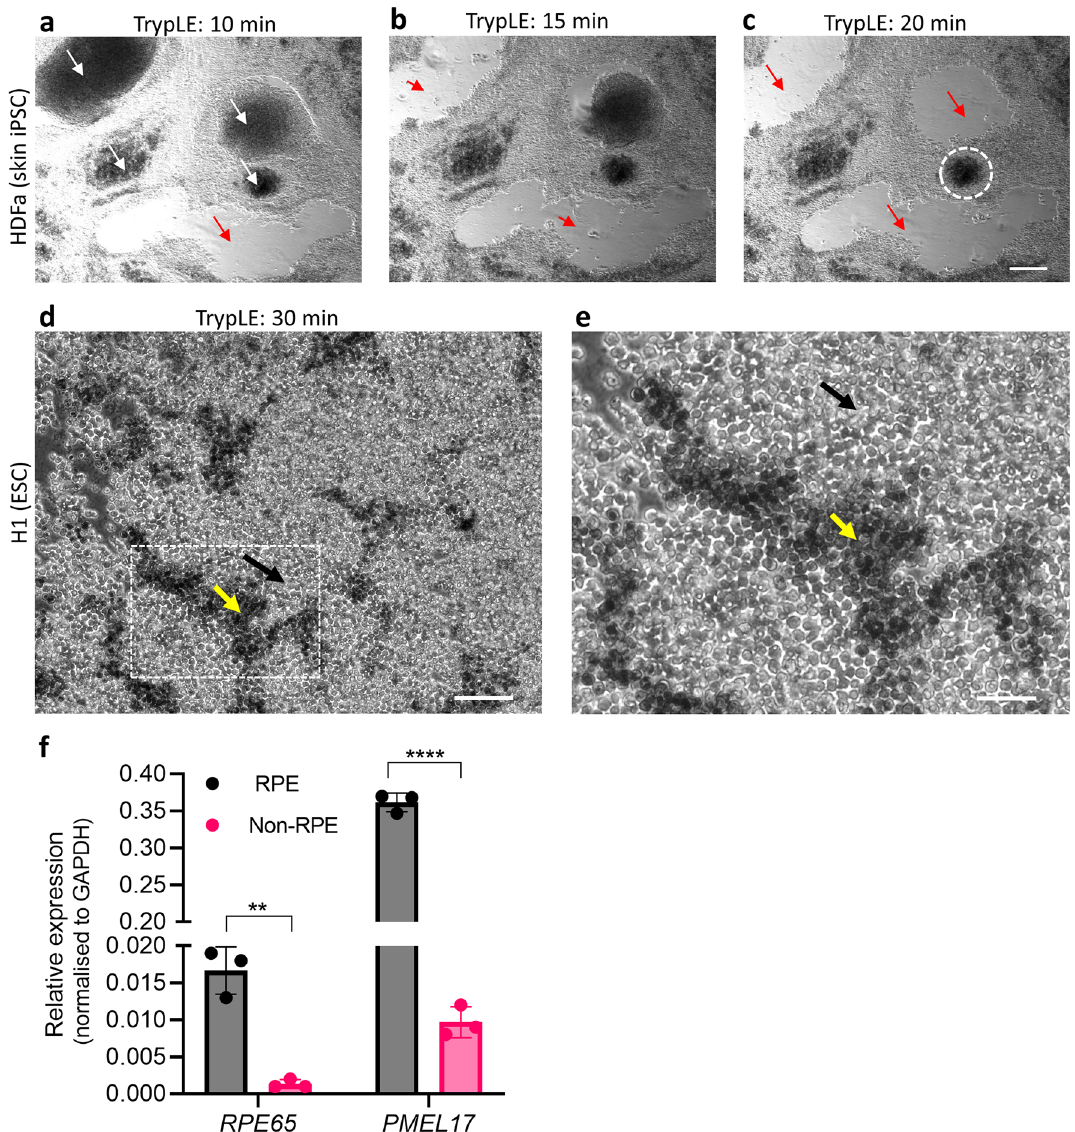
Figure 2. Heterogeneity in adherence of non-RPE cells from different stem cell sources. ( a ) Phase contrast images of HDFa (skin-iPSC) differentiation cultures showing dome-shaped non-RPE clusters of various sizes (white arrows) of darker contrast due to multi-layering rather than pigmentation. ( b and c ) Progressive detachment of the non-RPE clusters at 10, 15 and 20 min of TrypLE treatment, leaving gaps (red arrows). Scale bar, 200 μm. Majority of the non-RPE clusters detach within 30 min of treatment except for a small TrypLE- resistant cluster (white dotted circle). ( d ) Non-RPE cells (black arrow) in H1 (ESC) differentiation cultures after 30 min of TrypLE treatment intermingled with pigmented RPE cells (yellow arrow). Scale bar, 100 μm. ( e ) Magnified view of an area inside the box in field shown in ( d ). Scale bar, 50 μm. ( f ) RT-qPCR